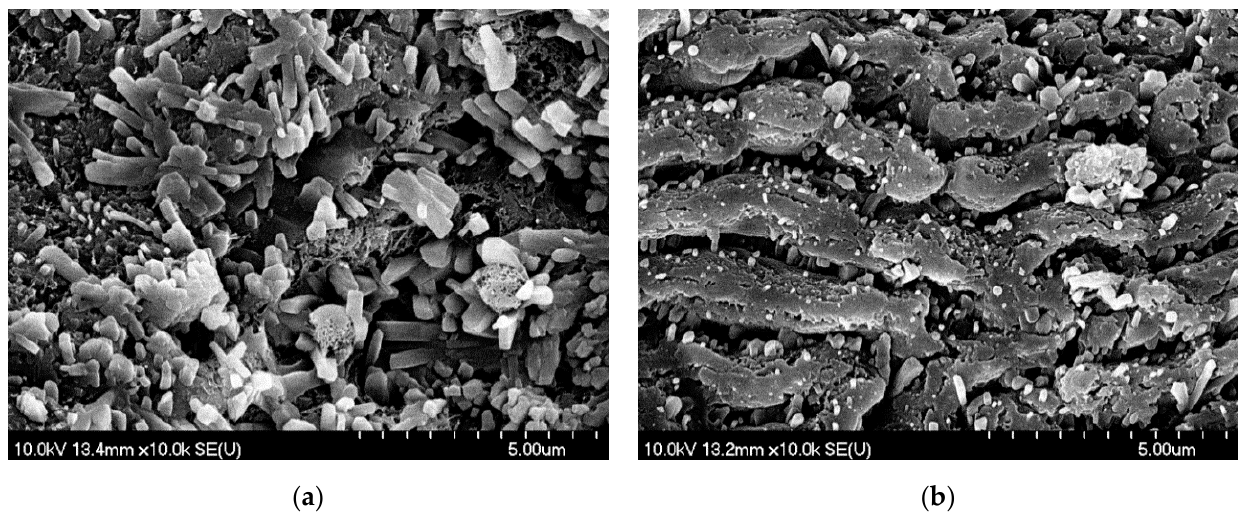
Figure 8. SEM pictures of the meloxicam pastille surface after PLA (at 1.5 J/cm 2 fluence): ( a ) random or flower-shaped, block-like structures; ( b ) parallel lines with approximately 1.8 µm period length. M: 10k.